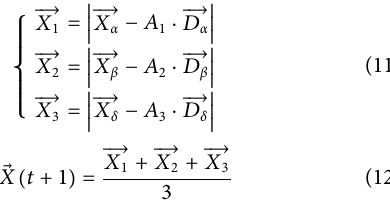
(cid:2) a , and (cid:2)A varies within the interval [ − 2 (cid:2) a , 2 (cid:2) a ]. When the value of A is within the interval and | a | ≤ 1, the wolf can attack the prey.